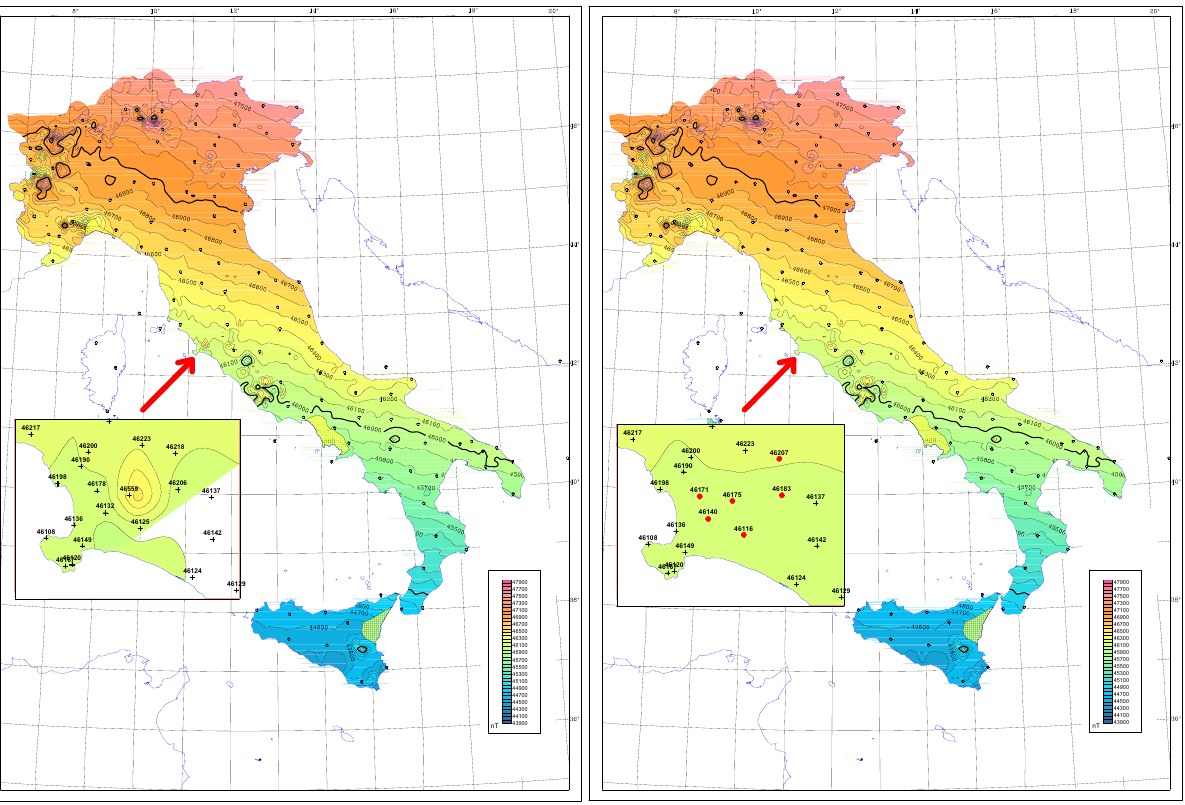
Figure 6. Two maps for comparison. Left: map of total field F at 2005.0 by Italian database with the enlargement of Albegna basin and val- ues. Right: map of F at 2005.0 by Italian database corrected after new data from survey described in this paper were included (red points in the